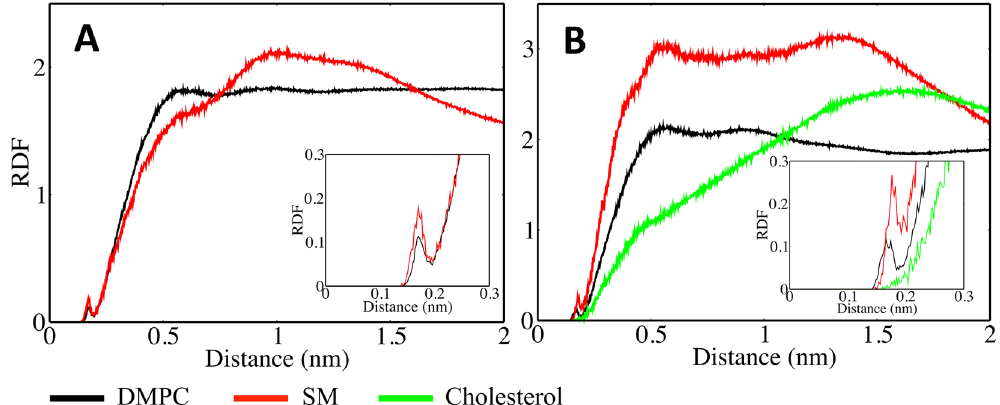
Figure 8. Molecular interactions of doxorubicin with individual components of the membrane bilayers: Radial distribution function of the DMPC, SM headgroups and cholesterol OH group from doxorubicin. ( A ) DMPC:SM [8:2] with doxorubicin and ( B ) DMPC:SM:Chol [7:1.5:1.5] with